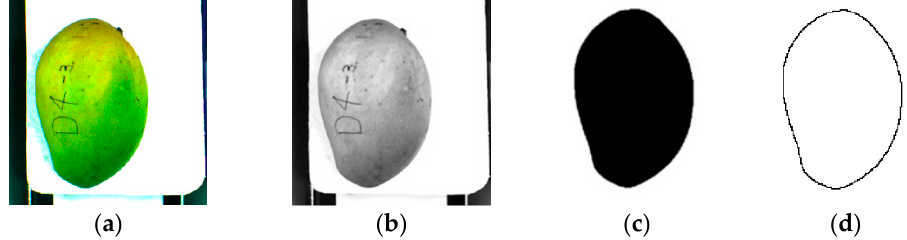
Figure 4. Image processing step involve in background removal for top view image. ( a ) Original RGB image; ( b ) Grayscale image from the B band; ( c ) Binary image after global threshold process; ( d ) Shape boundary of the mango.